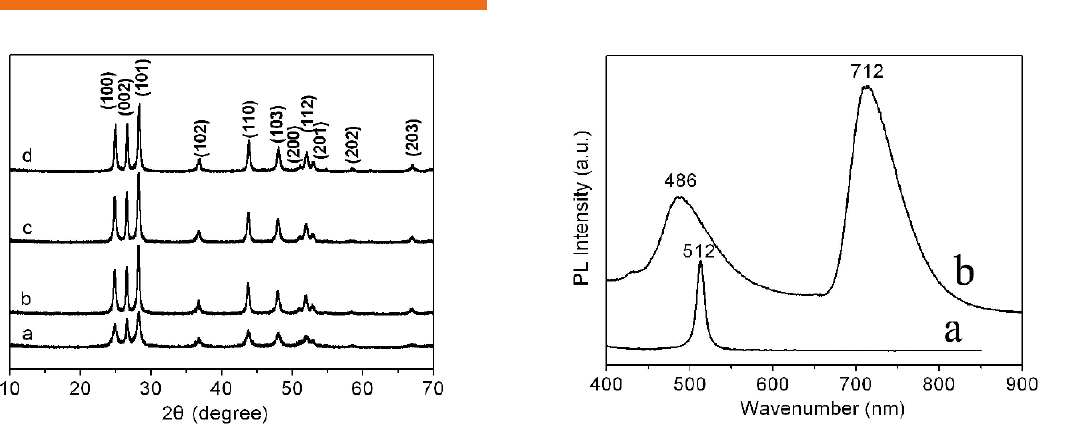
Figure 7. PL spectrum at room temperature: (a) bulk CdS; (b) the flower-like CdS